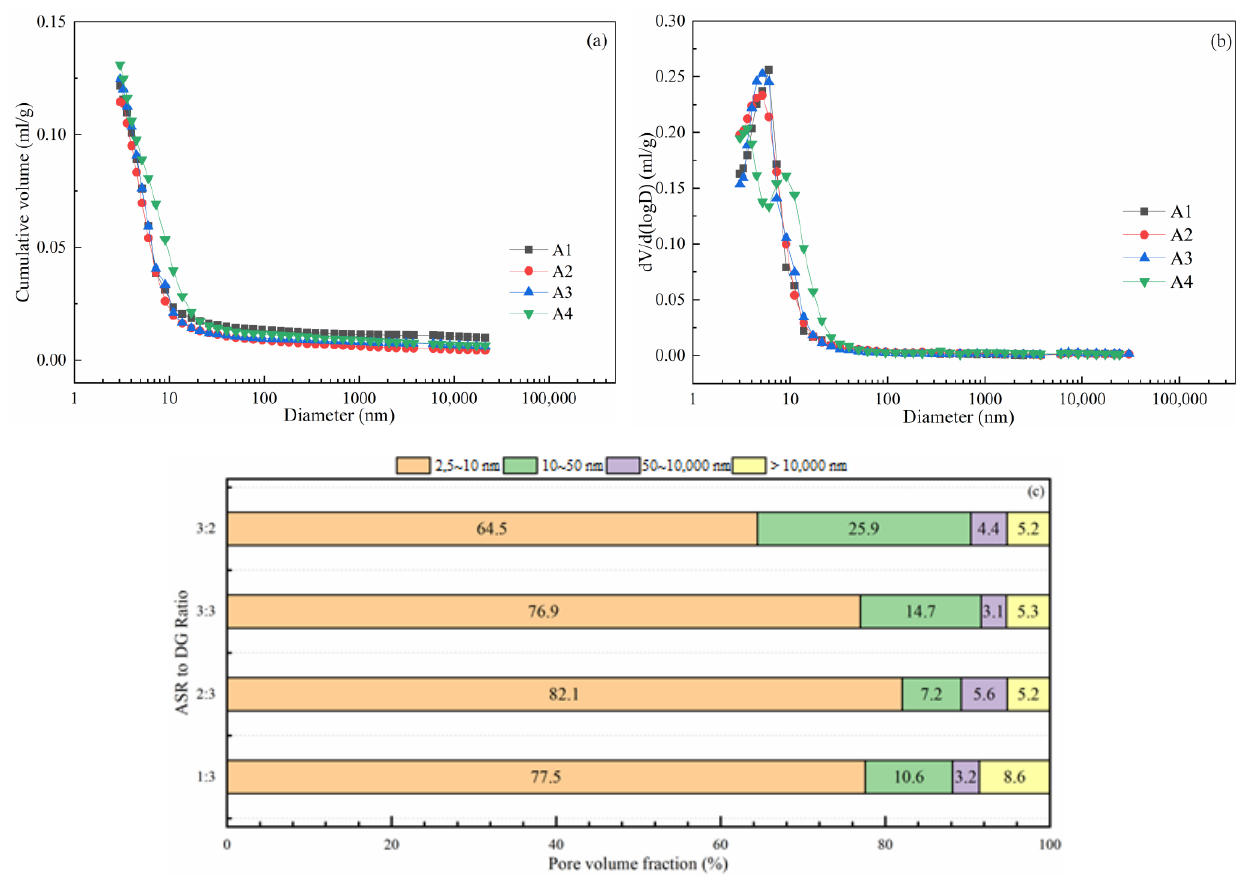
Figure 8. Pore volume and distribution of samples with different ASR-to-DG ratios at 180 days—( a ) cumulative pore volume, ( b ) dV/d(logD), and ( c ) pore-volume fraction distribution. Table 4. Porosity variation of different ASR-to-DG ratios at 180